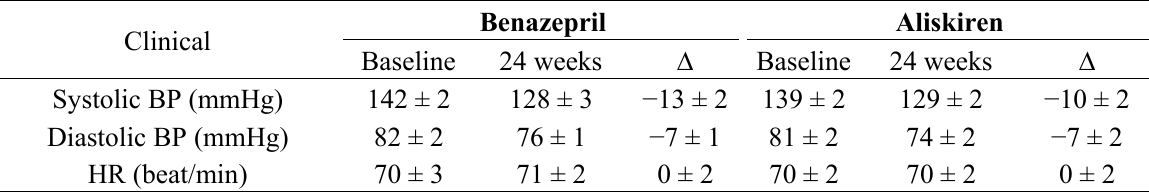
Table 3. Clinical BP and HR profile before and after add-on anti-hypertensive treatment.